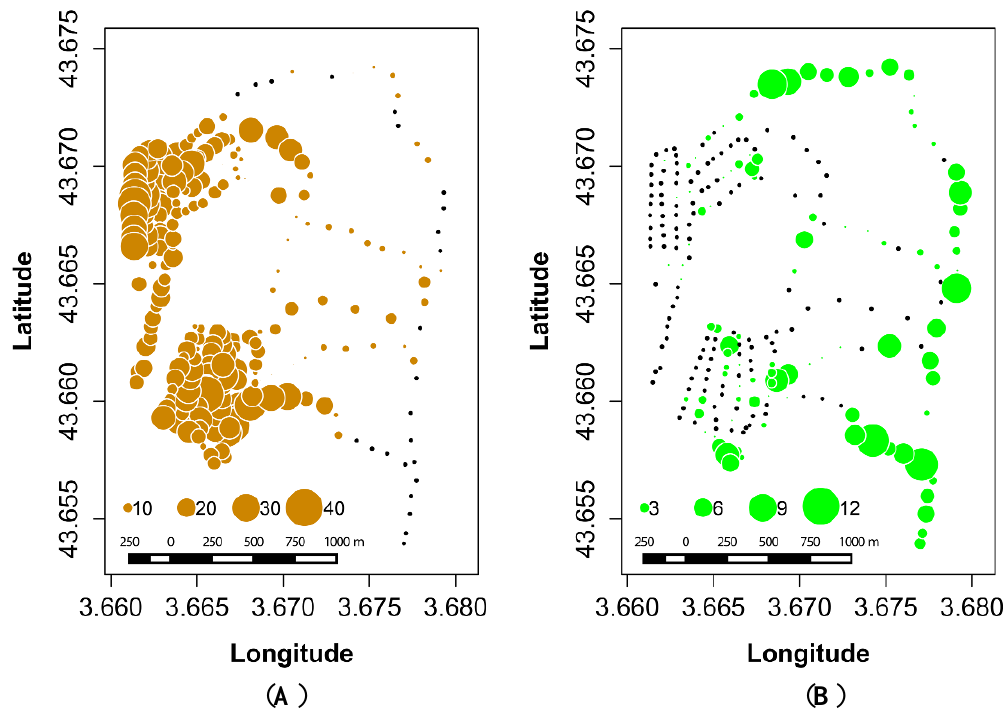
Figure 1. Number of deciduous ( A ) and evergreen ( B ) oaks in a 50 m radius around each nestbox in the study site. Nestboxes with no oaks in a 50 m radius are in black. Colored dot size is proportional to the number of oaks around each nestbox.